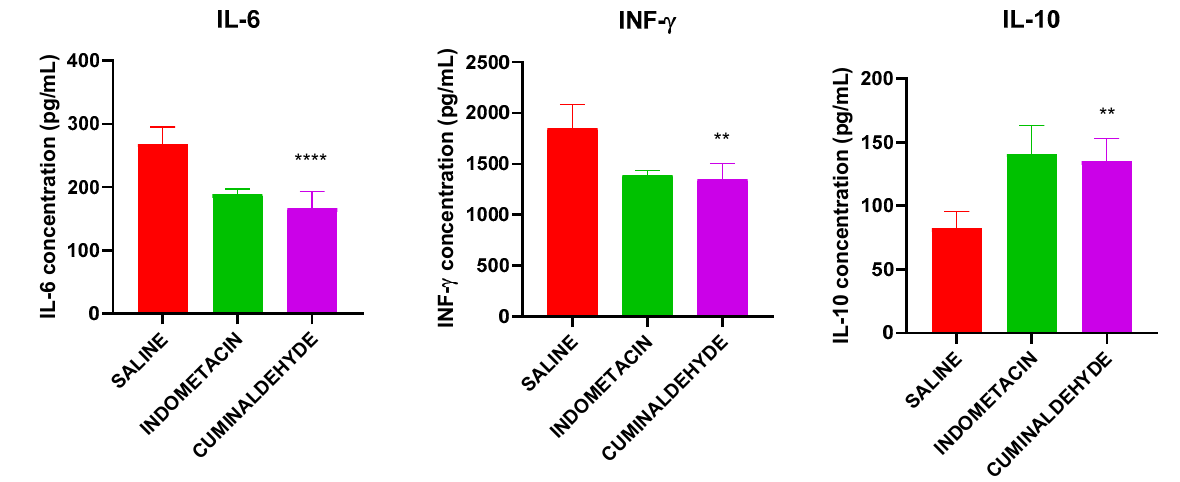
Figure 7. Concentration of the cytokines IL-6 (A), INF-y (B) and IL-10 (C) and TNF-a (D), evaluated by ELISA of the serum of the animals used in the experiments. **, **** Significant differences, at p < 0.005 and 0.0001, respectively, compared to the saline group (CTL − ); (one-way ANOVA; Tukey).